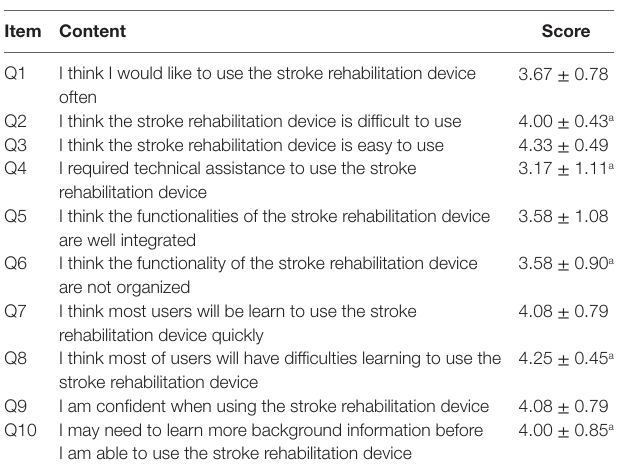
TaBle 6 | Score for each system usability scale item.